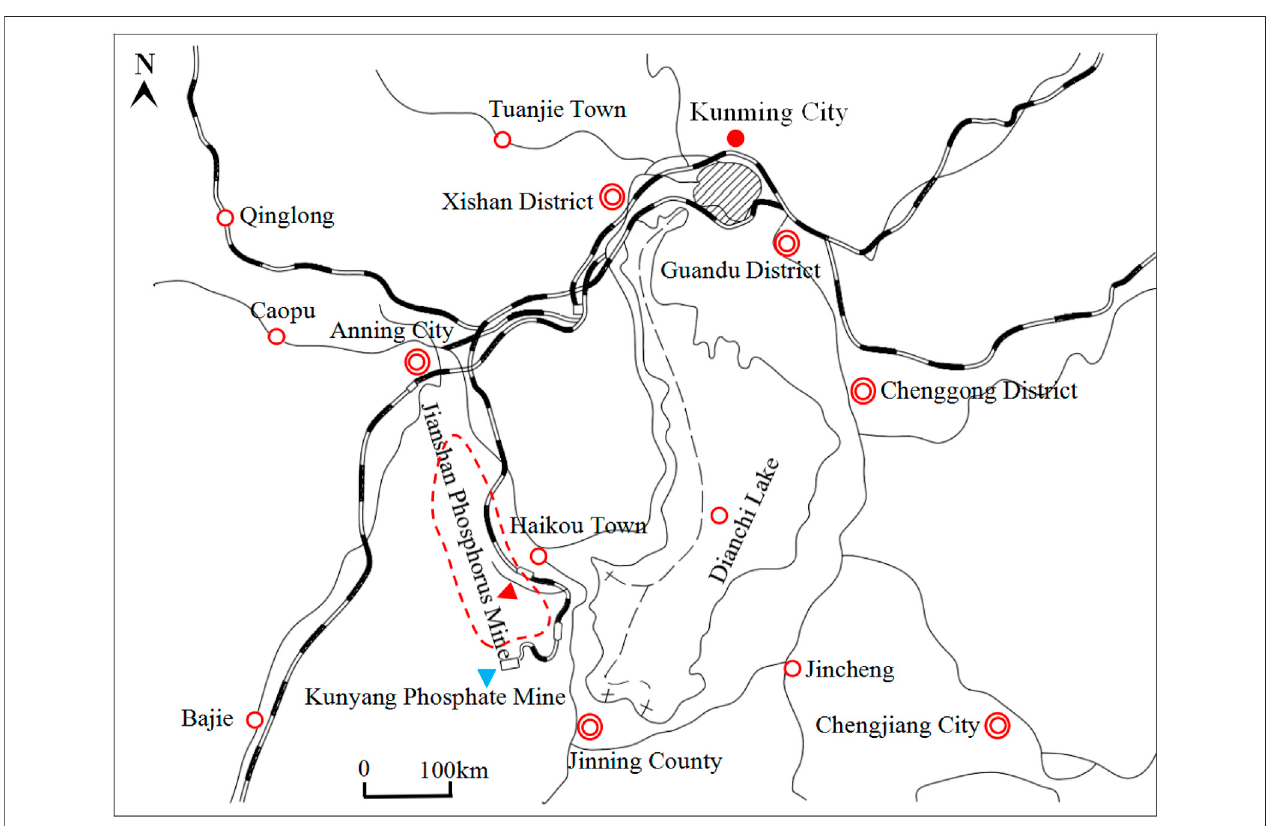
FIGURE 1 | Location map of Jianshan Phosphate